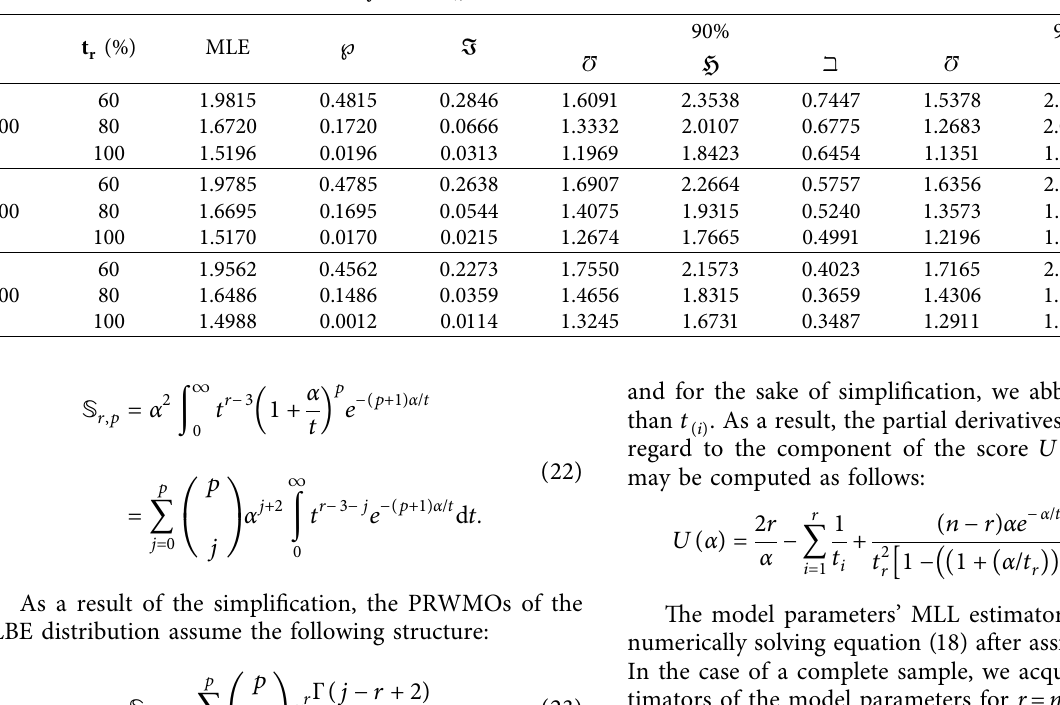
Table 2: MLE, ℘ , I , [ , H , and ℶ of the ILBE distribution for α � 1.5 under